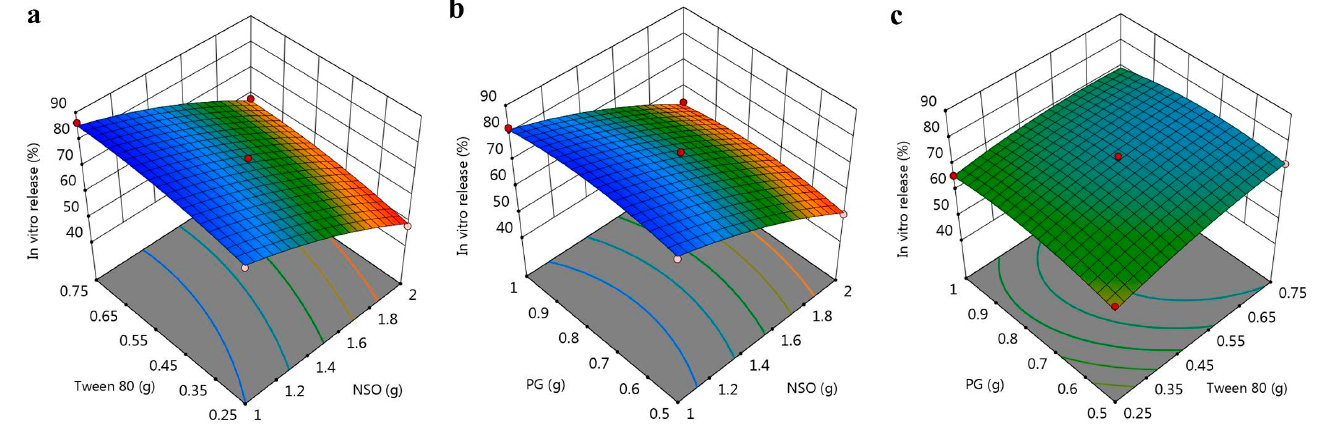
Figure 4. 3D response surface plot representing the effect of independent variables ( a ) NSO and Tween 80, ( b ) NSO and PG, and ( c ) Tween 80 and PG on in vitro release (R 2 ).